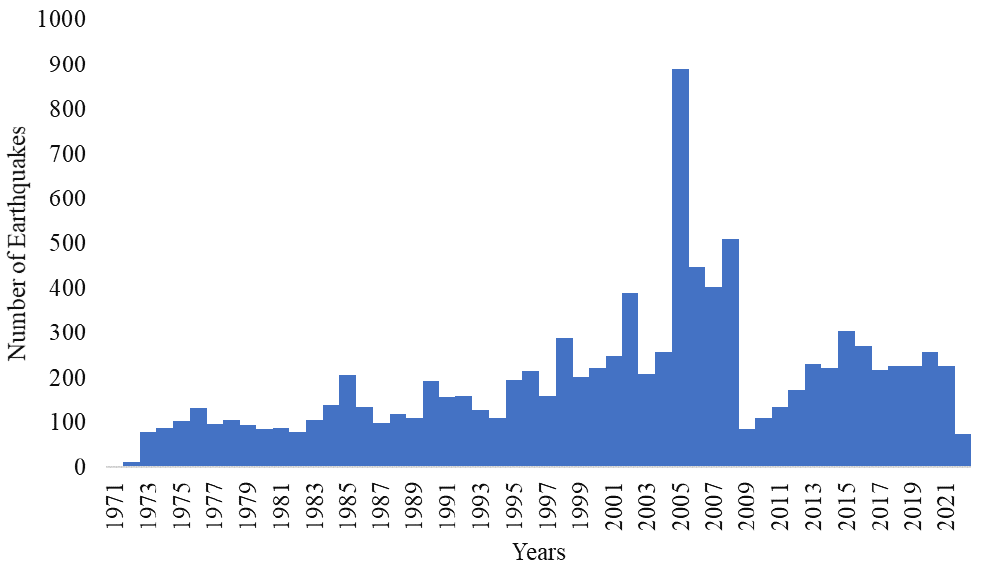
Figure 2. Frequency of earthquake occurrence per year from 1970 until 2021 in Northern Pakistan.